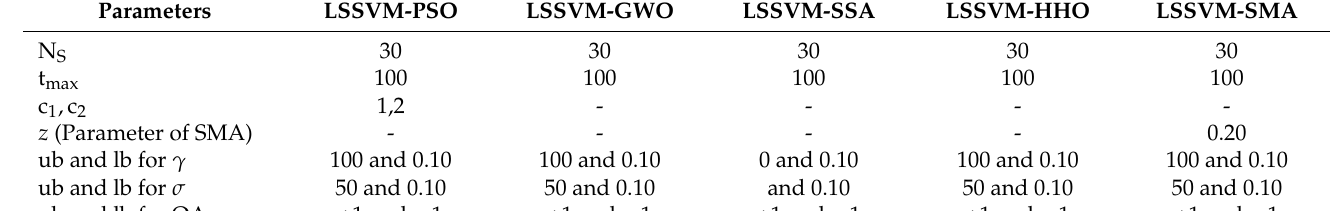
Table 2. Details of different parametric for hybrid LSSVMs.